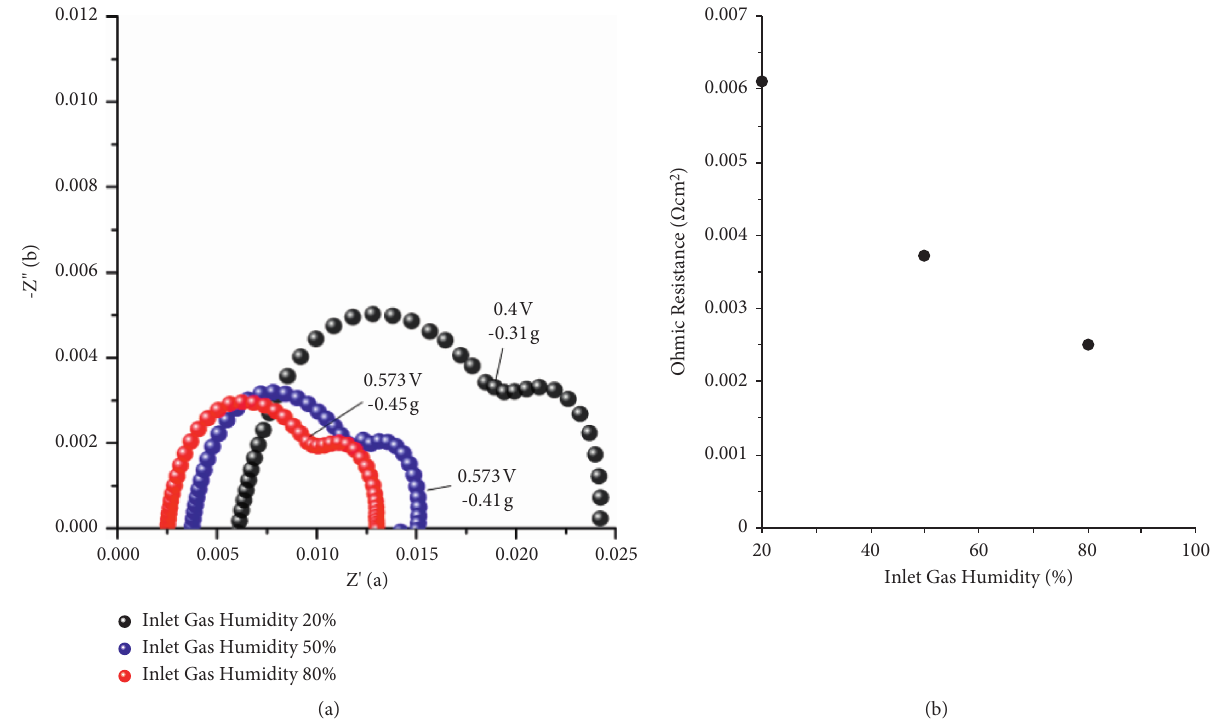
Figure 9: Effect of inlet gas humidity on the voltage, water content in the fuel cell, EIS, and ohmic resistance (inlet gas temperature 75 ° C, hydrogen stoichiometry 1.5, and air stoichiometry 2.5). (a) EIS. (b) Ohmic